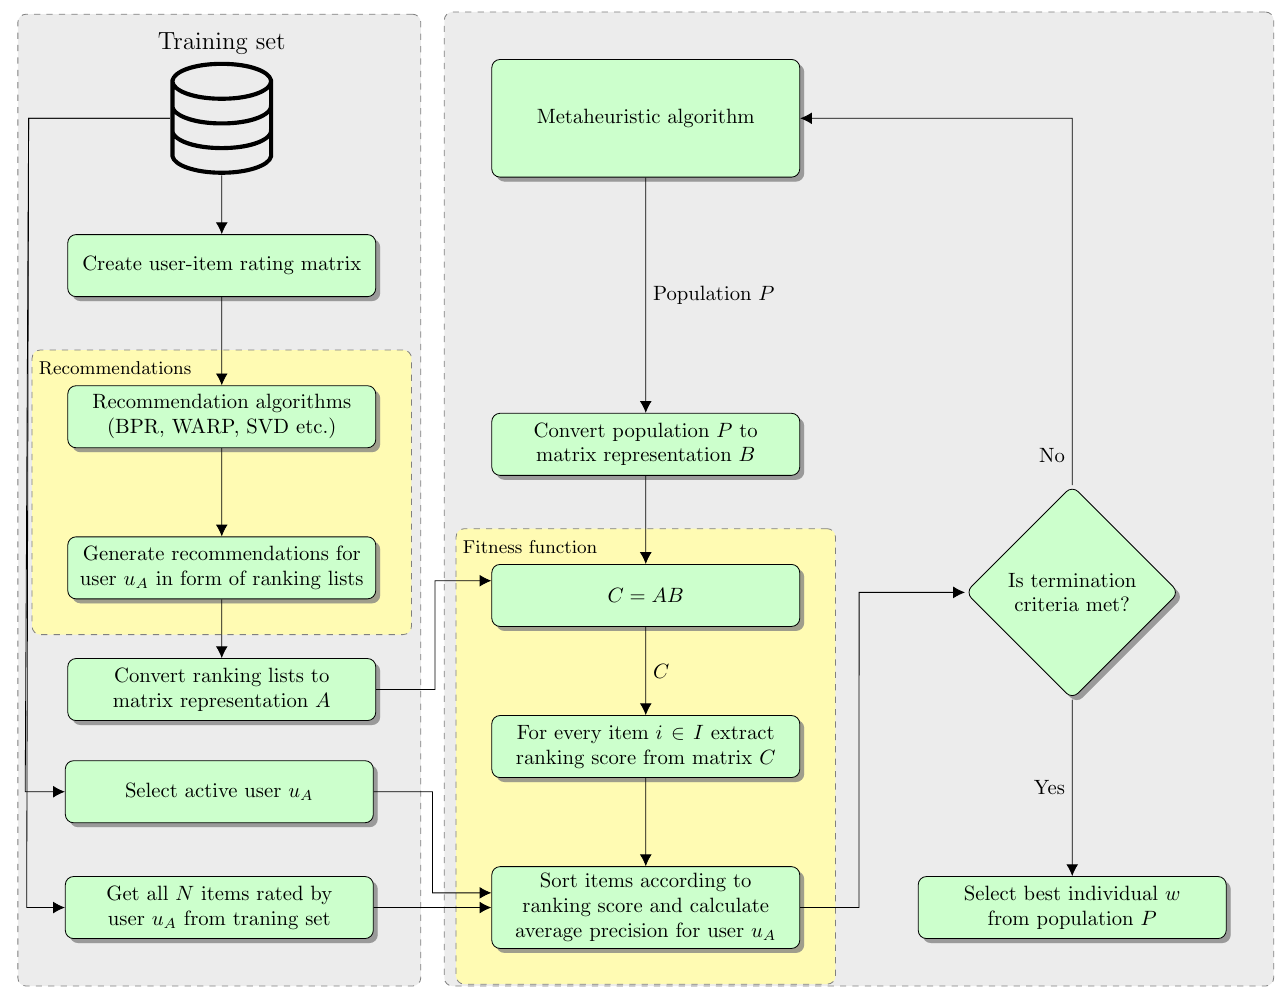
Figure 2. System architecture. The recommendation process is divided into two phases. In the first phase, recommendation algorithms generate recommendations in the form of lists, and active user u A is selected with all his N items from the training set. In the second phase, a metaheuristic algorithm works (in our case DE) with the dedicated fitness function, which allows for faster calculation of item scores, on the basis of which, new rankings will be